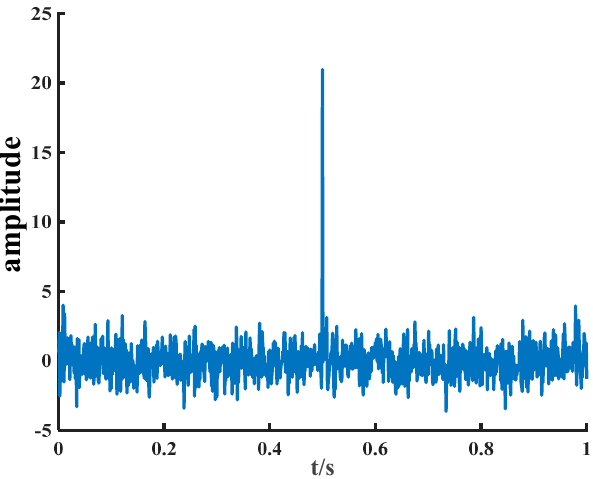
Figure 1. Multi-scale permutation entropy and multi-scale weighted permutation entropy of white noise with different scale factors and embedding dimensions. Under the above parameter conditions, a pulse signal is added to the Gaussian white noise to obtain the signal shown in Figure 2, where the sampling frequency is 1000 Hz, and the pulse signal is added at 0.5 s to collect a total of 1000 points.